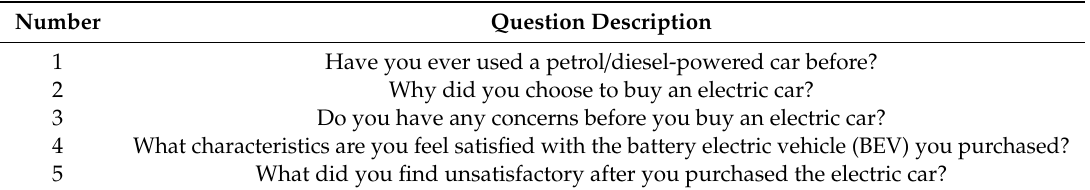
Table 3. Questions of semi-structured